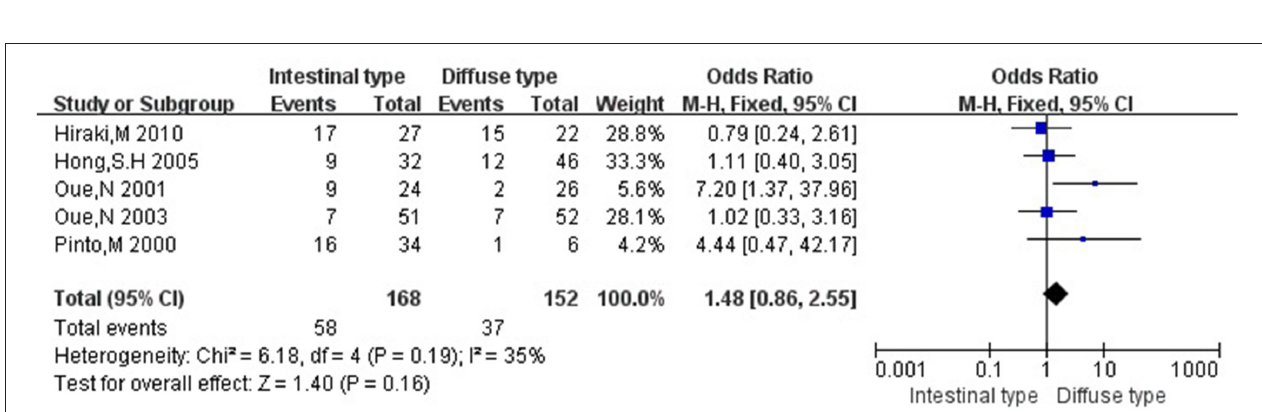
Frontiers in Physiology |